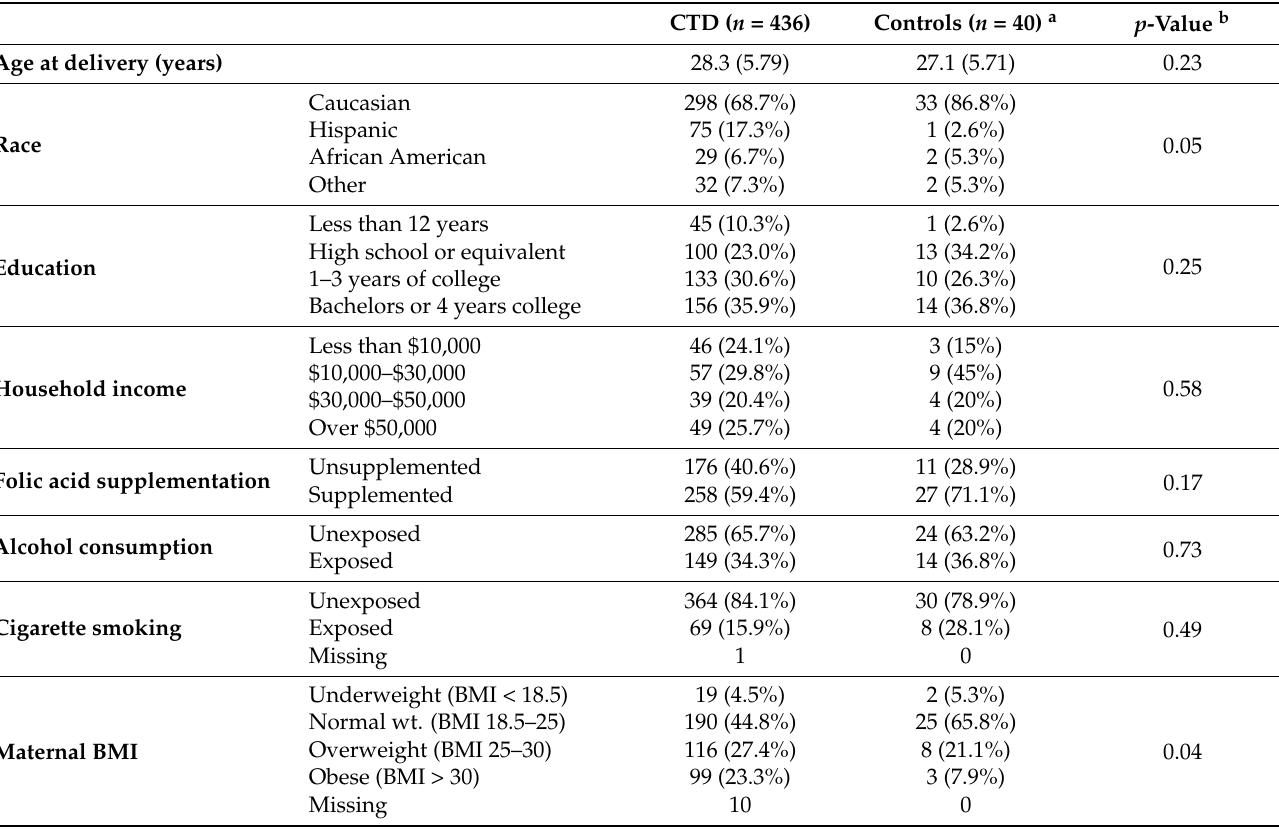
Table 2. Maternal demographics of discovery- and replication-phase samples used for DNA